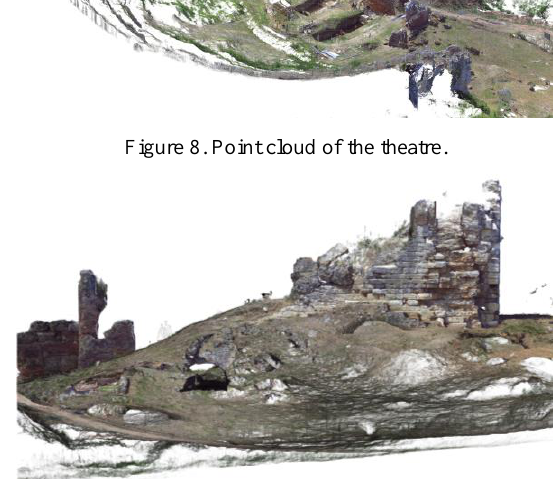
Figure 9. Point cloud detail.